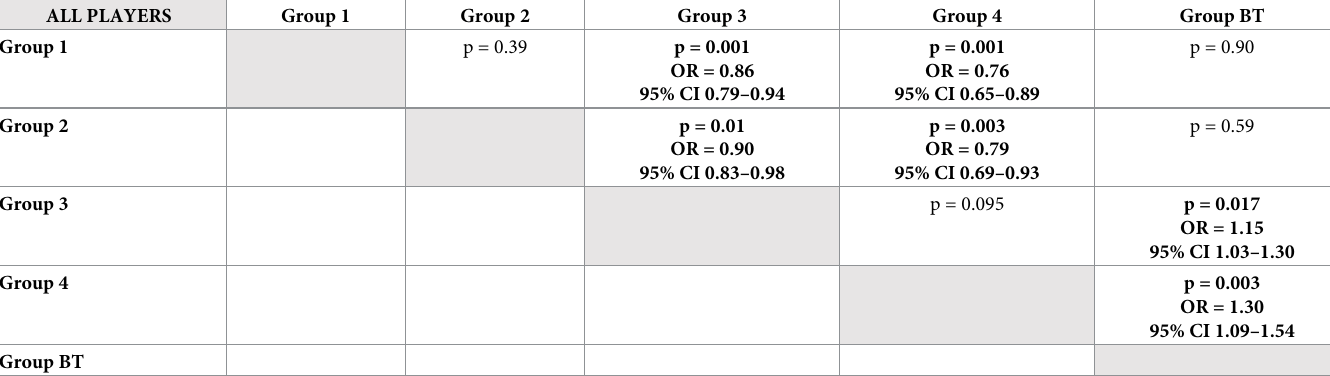
Table 4. Differences between the number of “early-born” players in various groups (p values)—Chi-square.